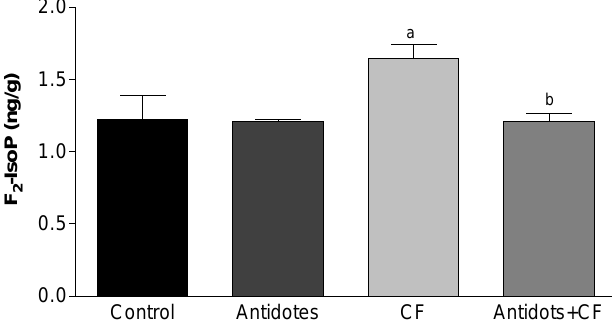
FIGURE 10. Effects of antidotes (MEM, 18 mg/kg and ATS, 16 mg/kg) given prophylactically, 45 and 15 min, respectively, before CF (1.5 mg/kg, s.c.) administration on F 2 -IsoPs levels in EDL muscles. Animals were sacrificed 60 min after last injection. Values are mean ± SEM (n = 4–6). a Significant difference between values from control and CF-treated rats ( p < 0.05). b Significant difference between values from CF- and Antidotes+CF– treated rats ( p <